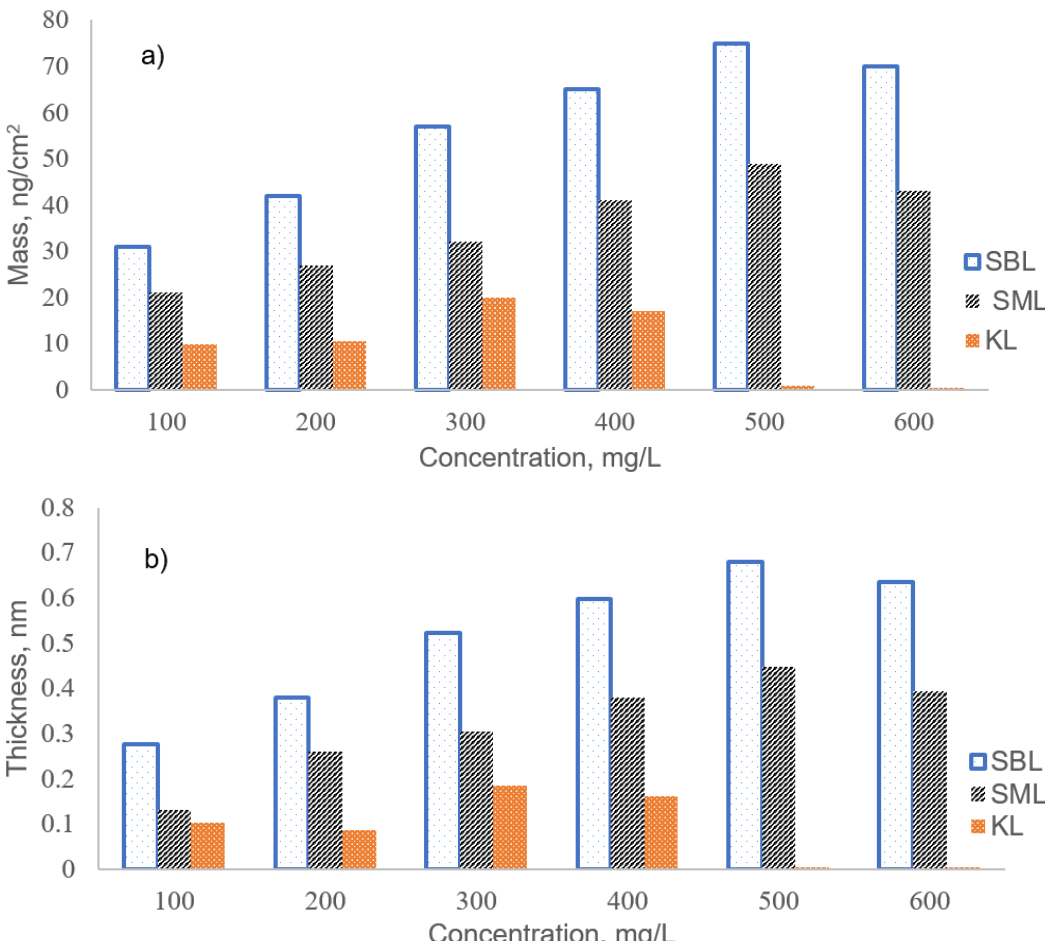
Figure 6. Adsorption of KL, SBL, and SML at different concentrations ( a ) Mass uptake ( b ) Thickness.